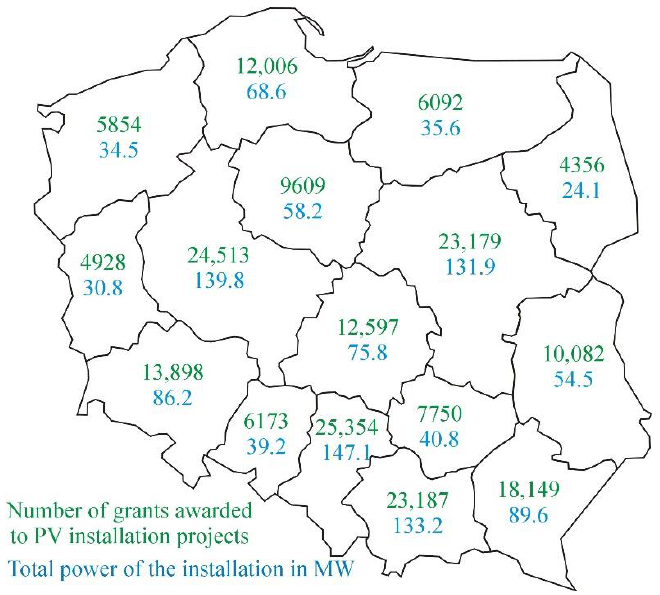
Figure 2. Results of the “My Electricity 2” program (own study from [59]).